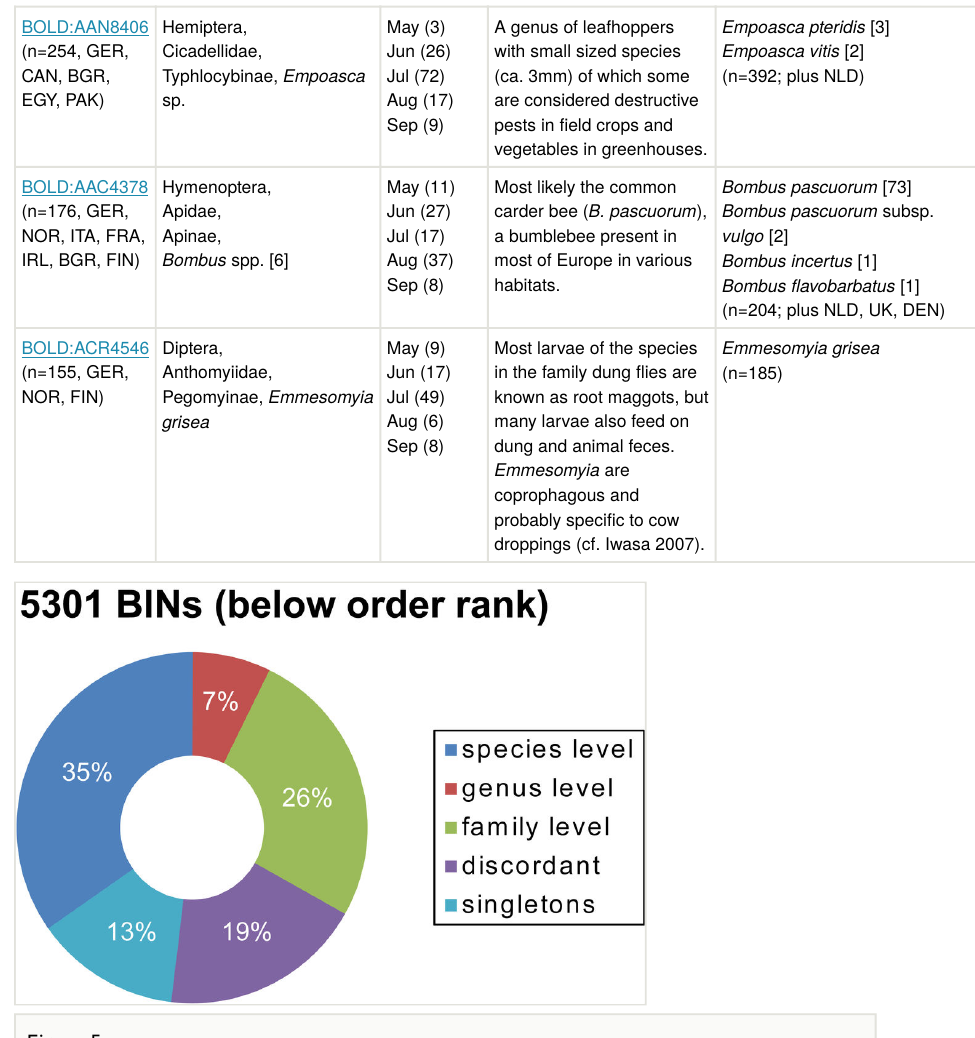
Figure 5. Summary of the BOLD BIN-discordance report for all BINs from both traps assigned to at least an order level. Depicted is the percentage of all BINs, which were grouped into taxonomic homogeneous or heterogeneous BINs and the percentage of BINs represented by only one